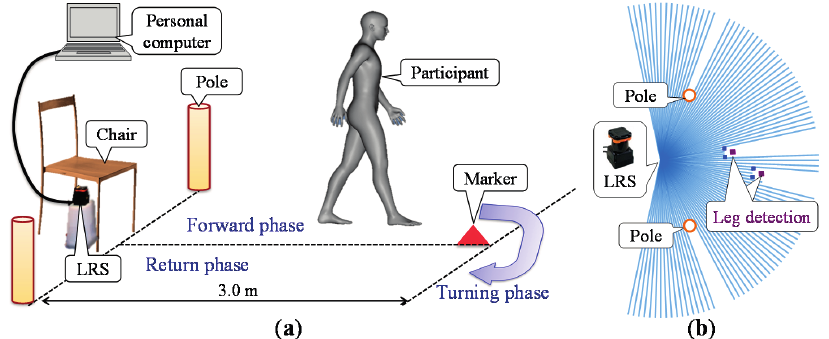
Figure 3. Gait measurement system using an LRS for the TUG. ( a ) System configuration. ( b ) Image of the LRS scan